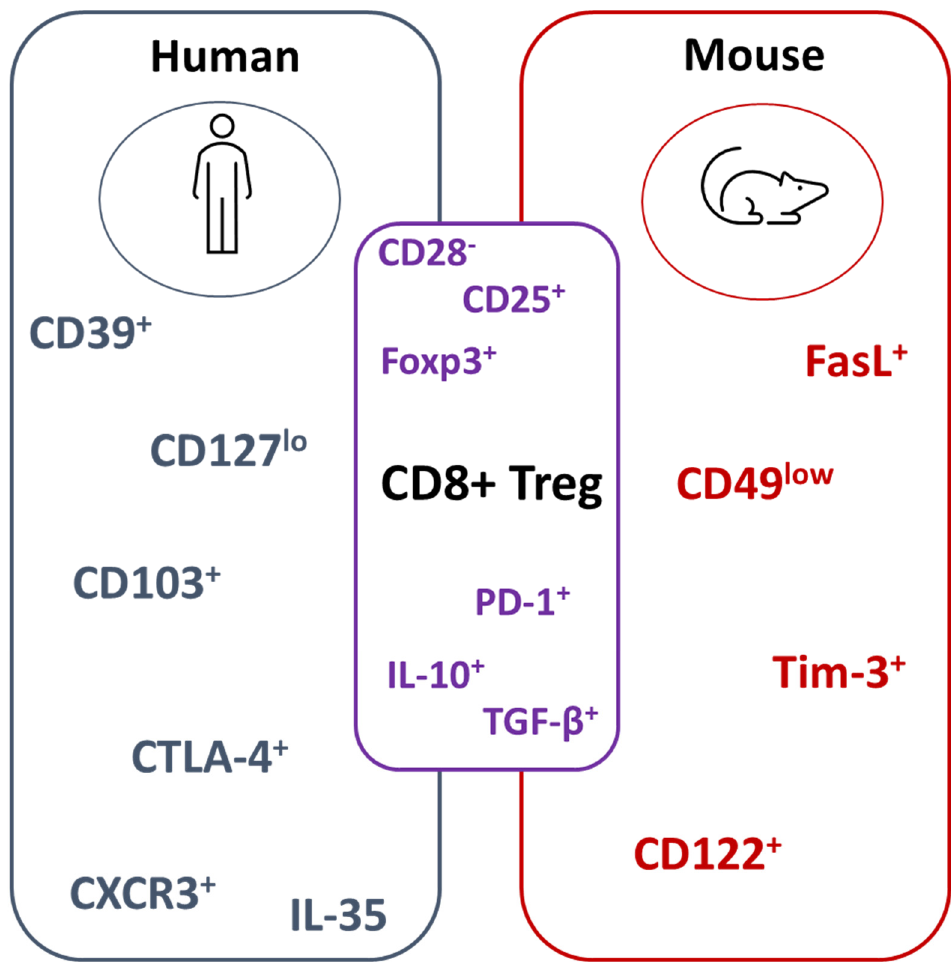
Figure 1. Summary of CD8 + Treg markers in mice and humans. CD8 + Treg phenotypic and functional markers differ between human and mouse studies. Well-characterized molecules between both species include the absence of CD28 and the expression of Foxp3. For functional readouts, IL-10 and TGF- β 1 has been reported. Cytotoxic T-lymphocyte-associated protein 4 (CTLA-4); programmed death-1 (PD-1); T-cell immunoglobulin and mucin domain 3 (Tim-3); transforming growth factor beta (TGF- β ).